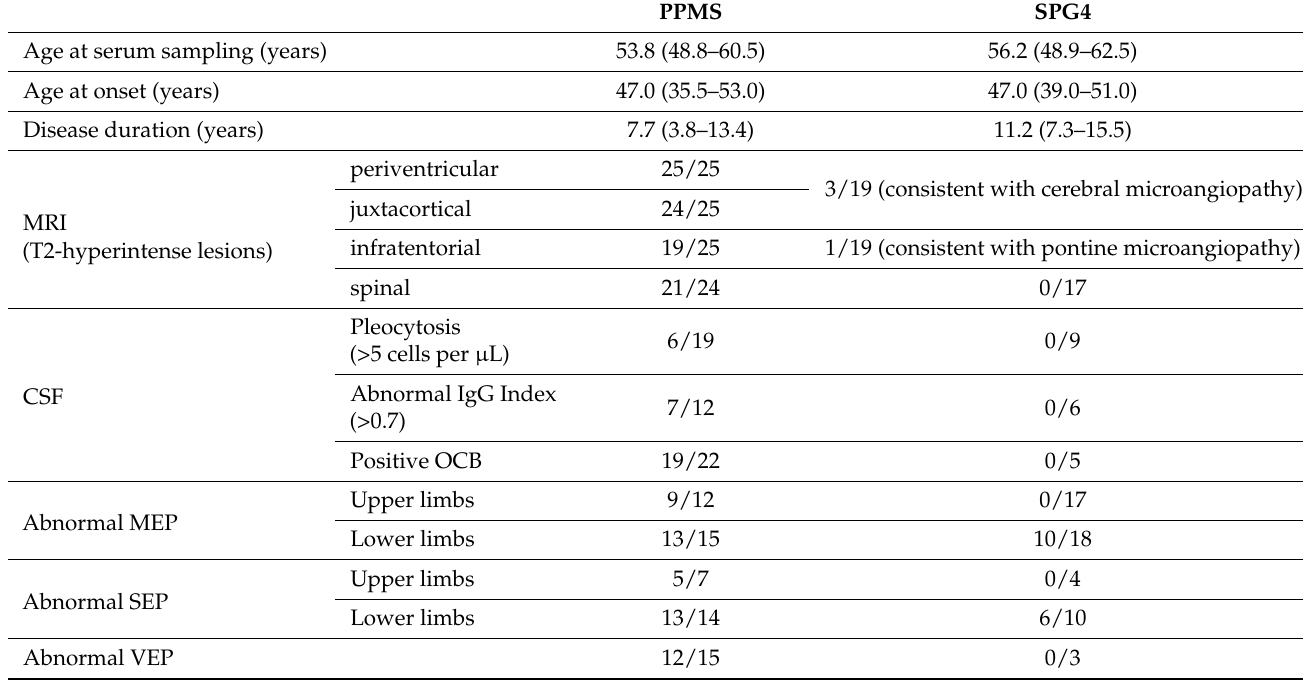
Table 1. Demographic data, MRI, evoked potentials and cerebrospinal fluid analysis in PPMS and SPG4